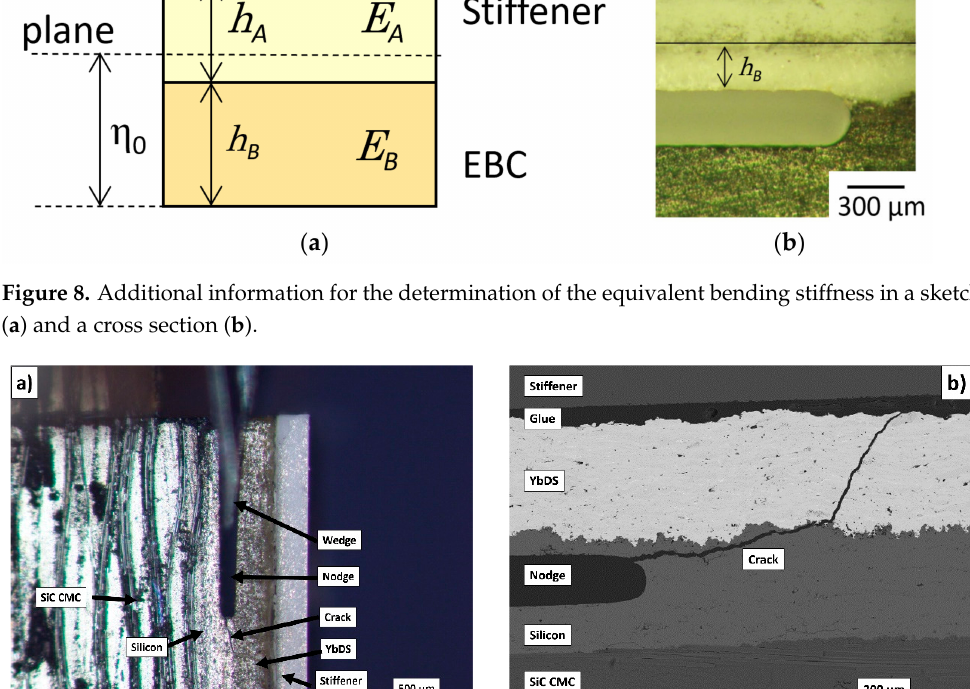
Table 3. Measured displacement, load, notch length and calculated interface toughness for all sample types.